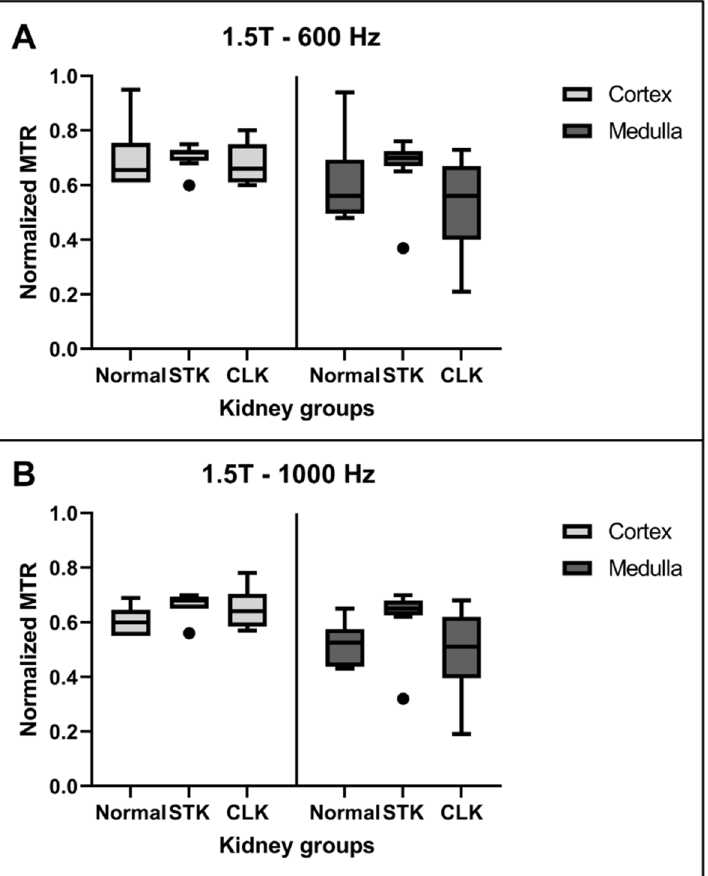
Figure 3. Normalized MTR values at the first timepoint at 1.5T with an offset frequency of 600 Hz ( A ) or 1000 Hz ( B ) for normal, stenotic (STK), and contralateral (CLK) kidneys cortex and medulla. There were no significant differences among any regions or frequencies.